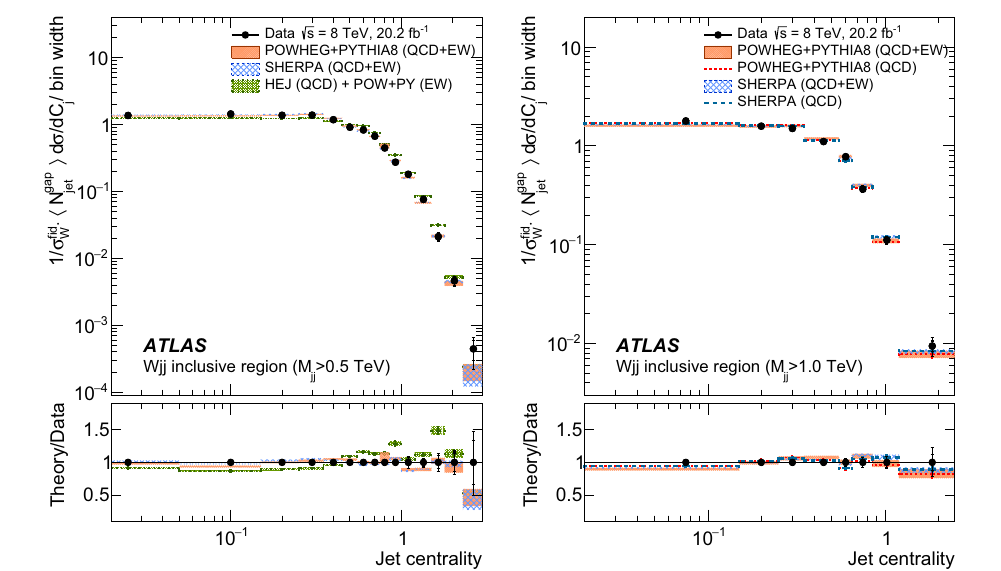
Fig. 22 Unfolded normalized differential QCD+EW W jj production cross sections as a function of jet centrality for the inclusive fiducial region with M jj > 0 . 5 TeV ( left ) and 1.0 TeV ( right ). Both statistical